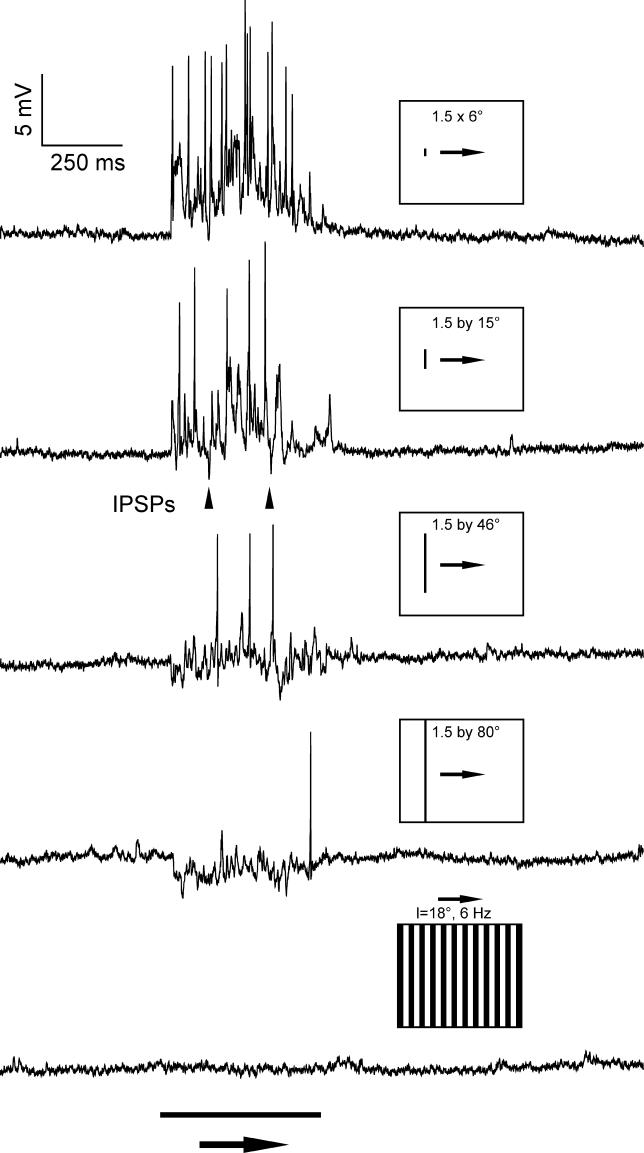
Complex Spatial Inhibition in an STMD Neuron Displaying Mixed Graded/Spiking ResponsesSmall targets elicit excitatory postsynaptic potentials (EPSPs) and monophasic spikes riding on a net graded depolarization. As length of a bar stimulus is increased, discrete IPSPs (arrowheads) become evident, eventually summing to produce net hyperpolarized responses for long bars. In each case, the bar stimuli were drifted through the receptive field at 75°/s. A drifting grating stimulus with similar spatio-temporal properties (temporal frequency 6 Hz, spatial wavelength 18°) elicits no post-synaptic potentials.